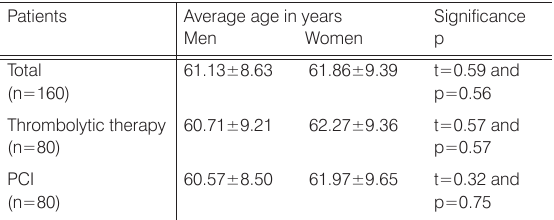
Table 1. The basic demographic characteristics of patients